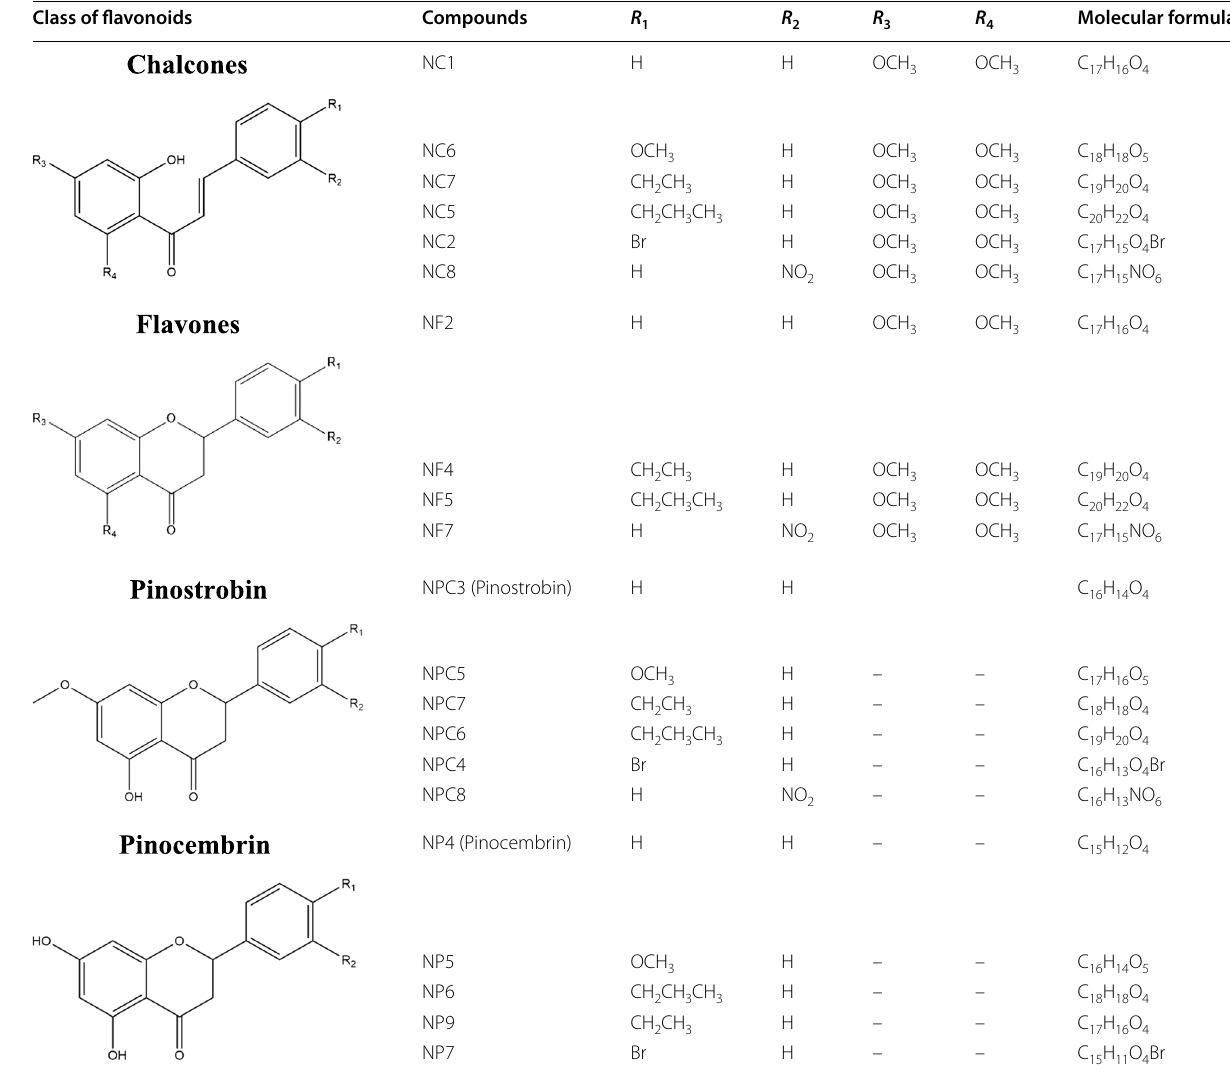
Table 1 Series of synthesized flavonoids from IOS Class of